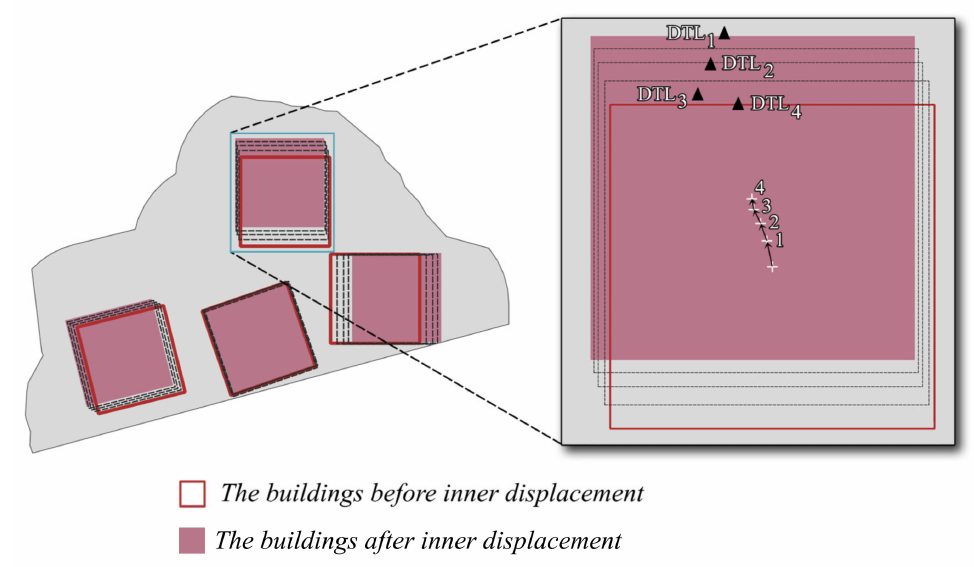
Figure 10. An illustration of the inner